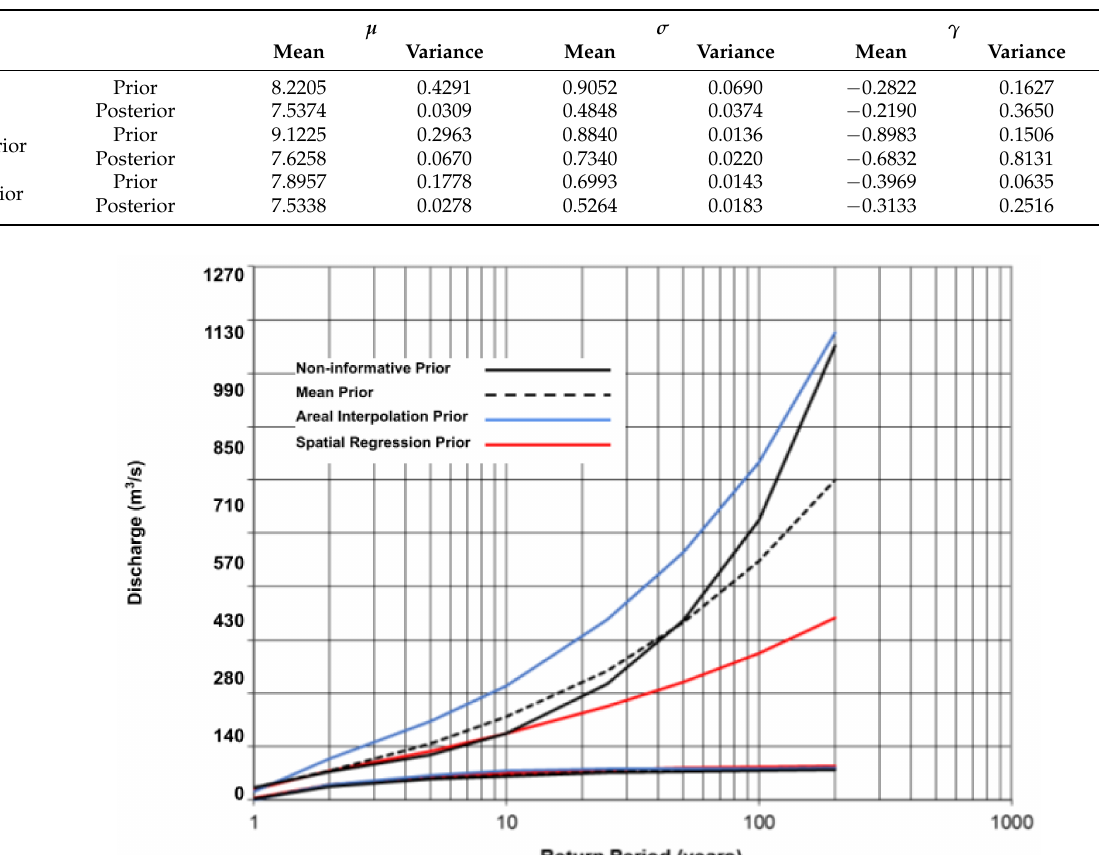
Table 8. Different prior types and associated posterior distributions.